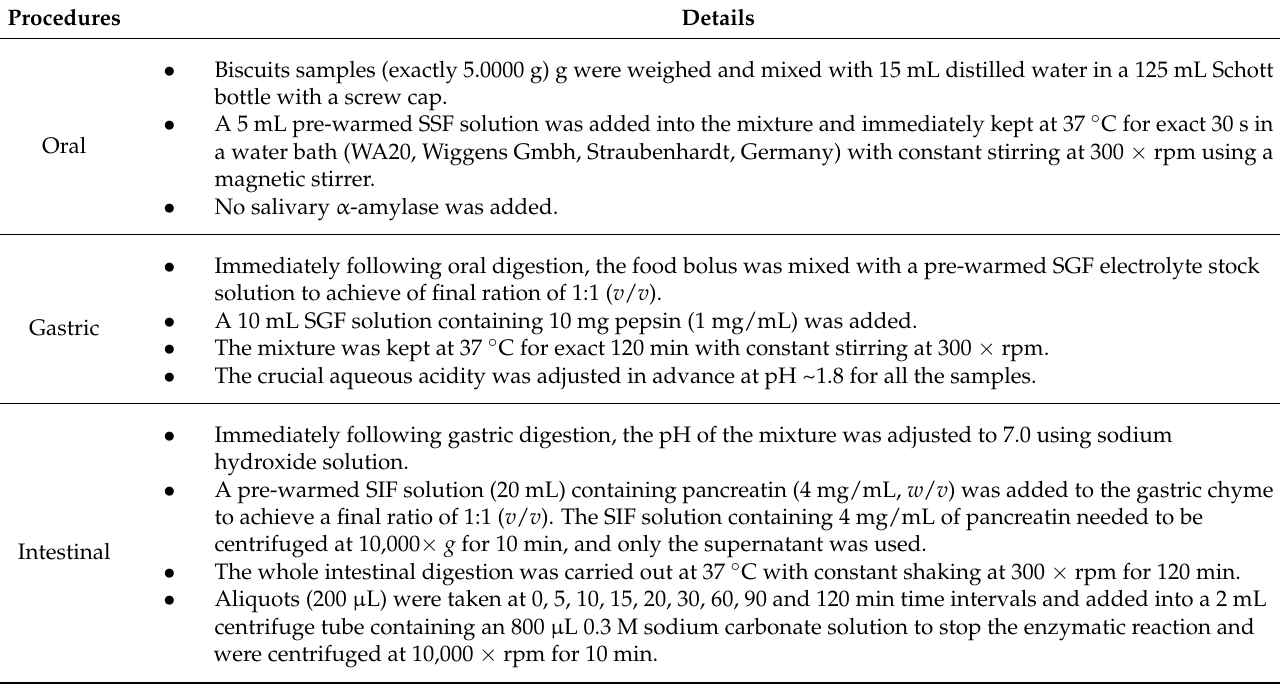
Table 2. In vitro digestion procedures of standard biscuits using INFOGEST